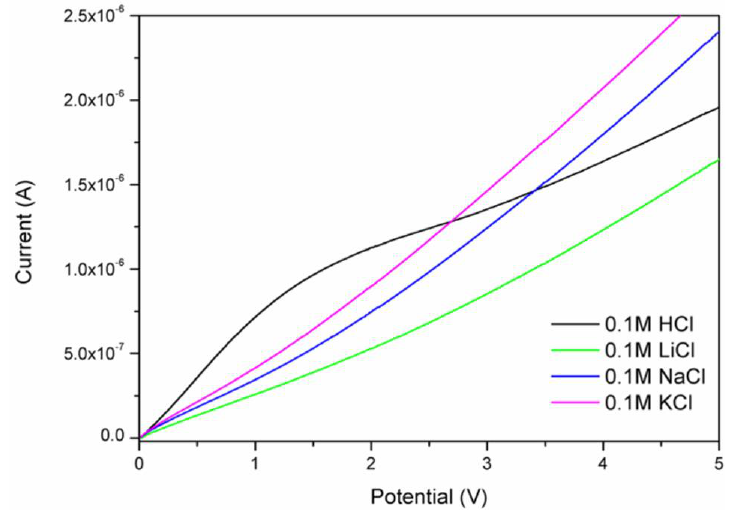
Figure 5. Linear sweep voltammetry (LSV) curves for different 0.1 M electrolyte solutions.